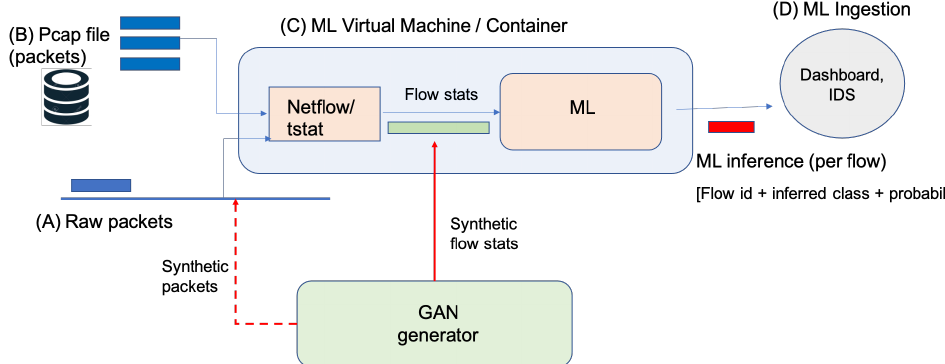
Figure 8. Integration of GAN synthetic traffic into ML